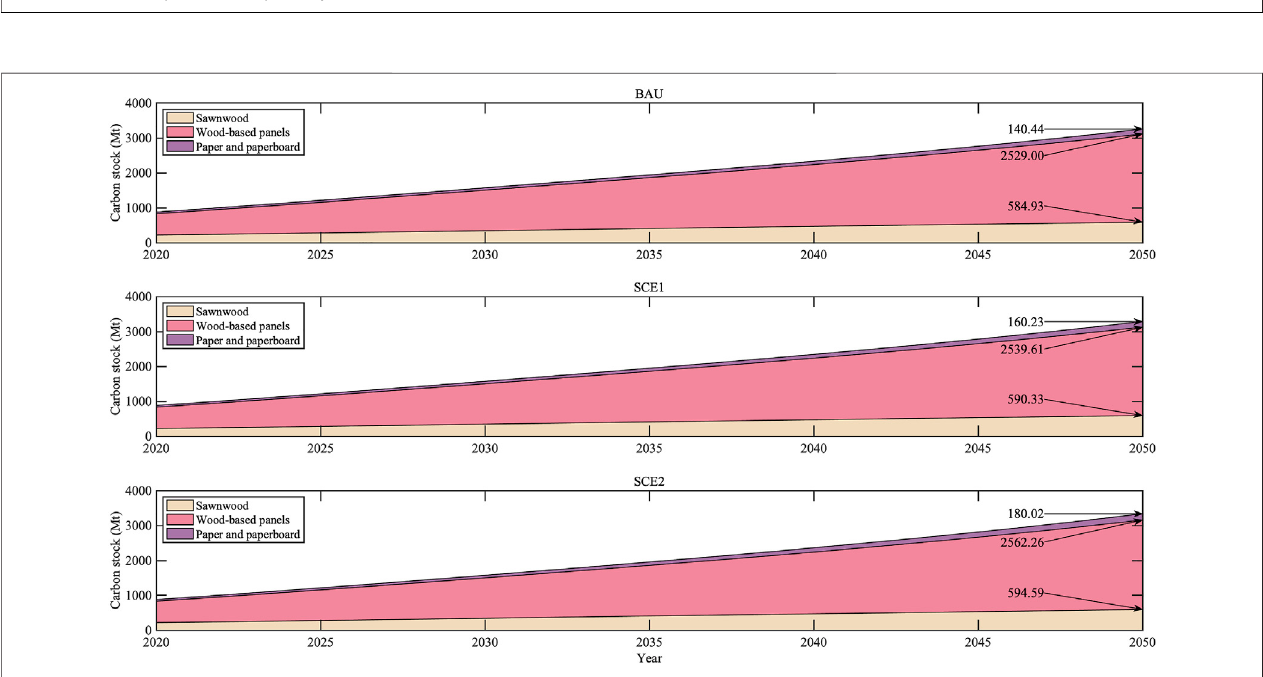
FIGURE4| Carbonstockunderdifferentwoodutilization scenariosfrom2020to2050.Thecarbon stockheretookintoaccountboth in fl owanddecay.Theblack arrows and numbers on the right side of the fi gure show the carbon stock of three HWP semi- fi nished products in 2050, respectively.